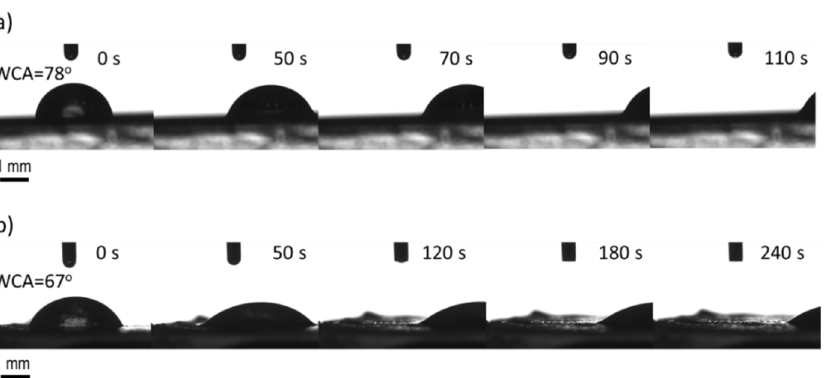
Figure 7. Representative sliding behavior of water droplet at 10° tilting on ( a ) PDMS/PS/BSO-PU and ( b ) PDMS/PS/BSO-PE.